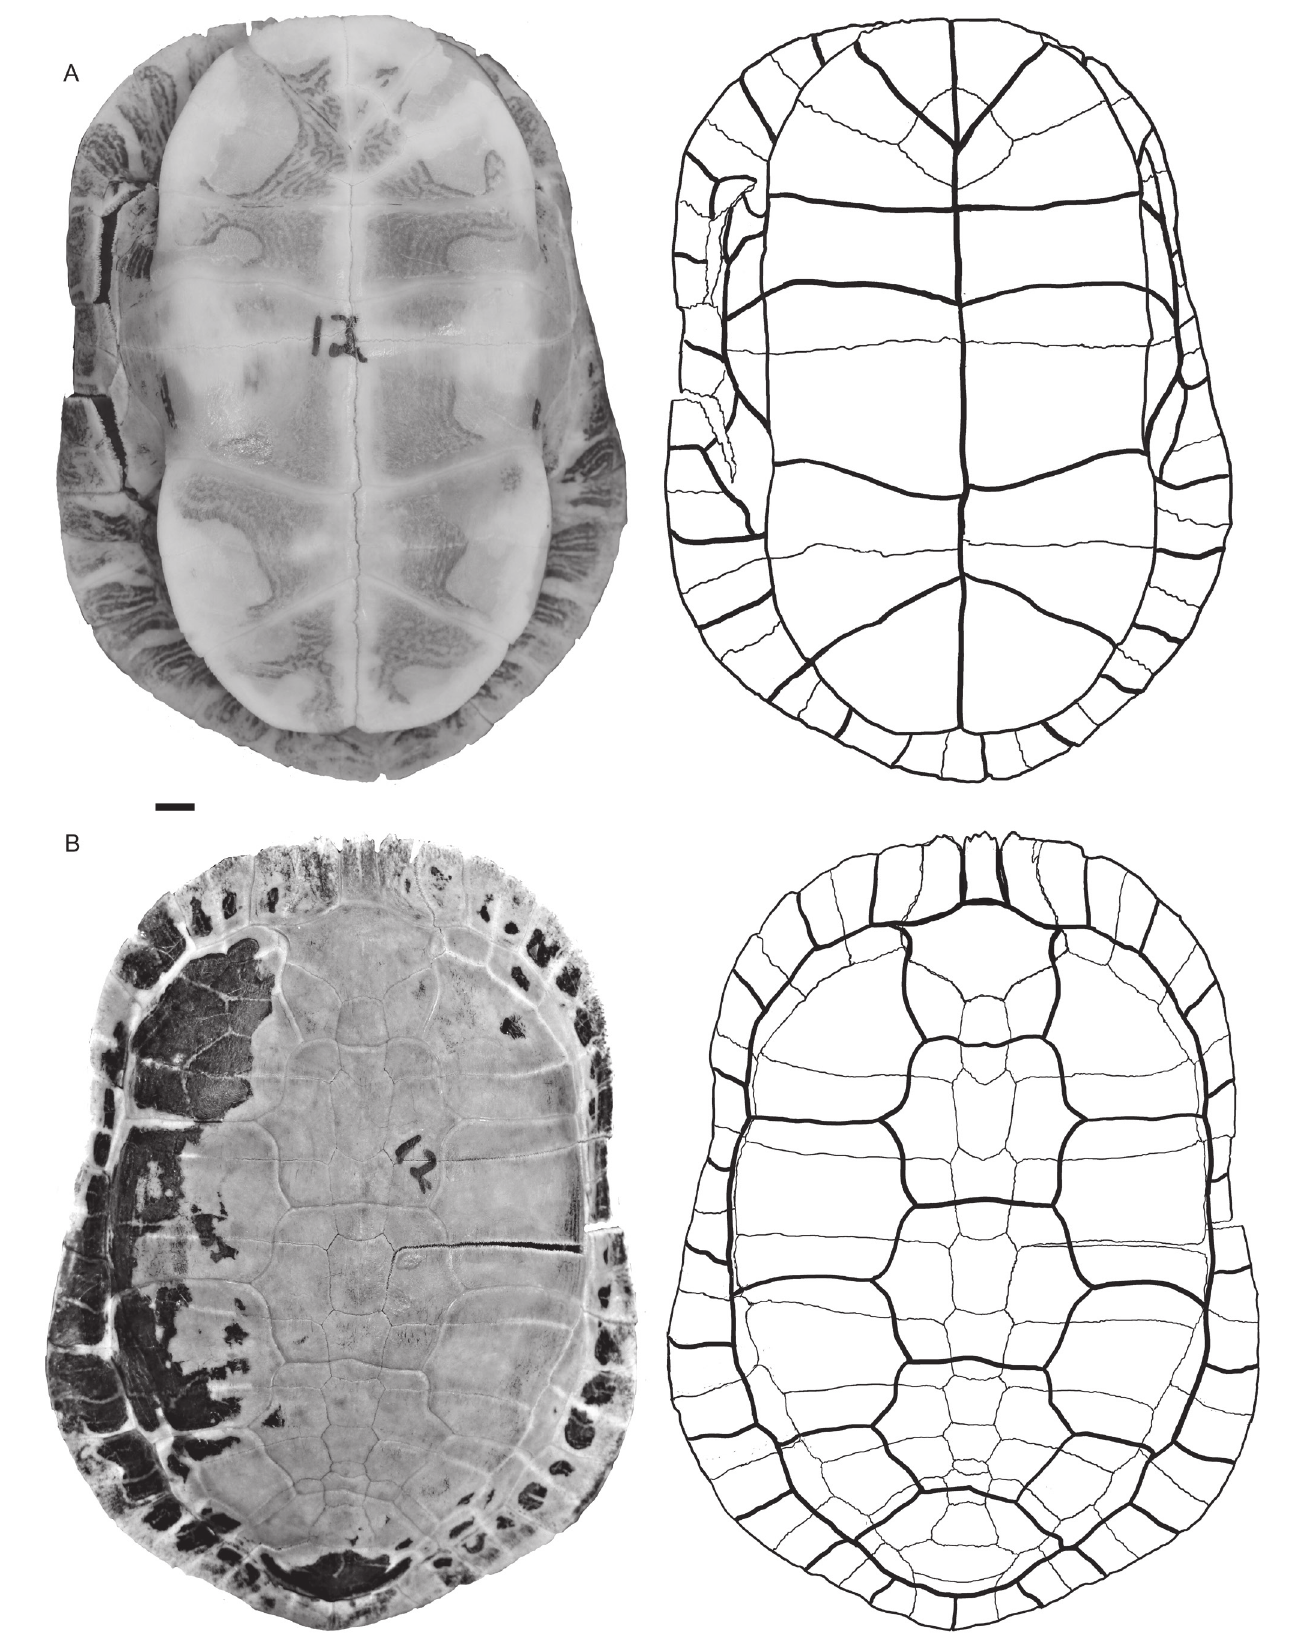
Figure 4. Chrysemys picta bellii, Neb 12. A, plastron and B, carapace. Arrow indicates missing bone. Dashed lines indicates indeterminate scute imprint, suture, or border due to damaged or missing bone. Scale bar = 1